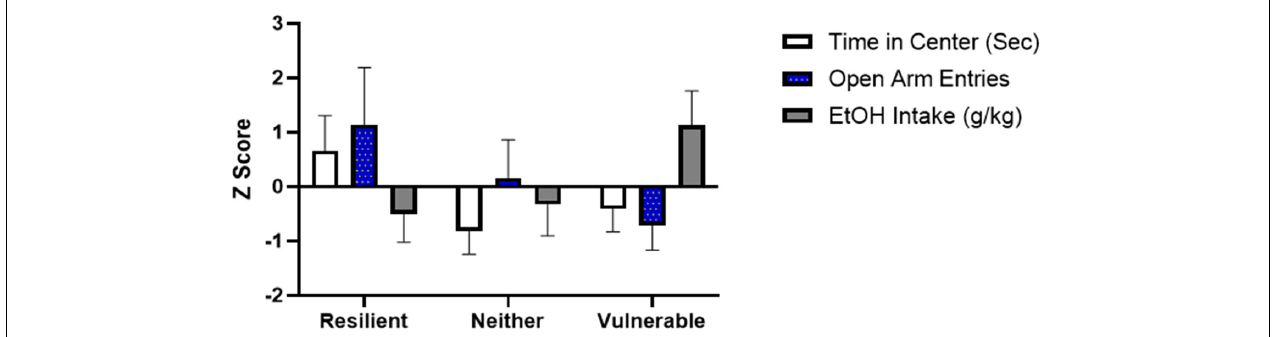
TABLE 2 | Resilient, neither, and vulnerable K -means cluster for open field test (OFT) time in center, elevated plus maze (EPM) number of open arm entries, and ethanol consumption during weeks 6–8. Resilient ( N = 4) Mean ( SD ) Neither ( N = 6) Mean ( SD ) Vulnerable ( N = 7) Mean ( SD ) F pairwise contrasts OFT 1.32 (0.88) − 0.70 (0.58) − 0.15 (0.57) 11.81*** 1 > 2***, 1 > 3** EPM 1.11 (1.05) 0.14 (0.70) − 0.75 (0.45) 9.08** 1 > 3*** EtOH weeks 6–8 − 0.75 (0.55) − 0.59 (0.60) 0.94